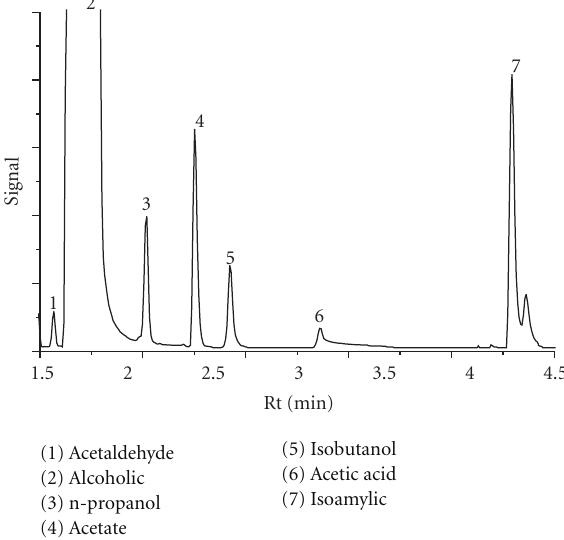
Figure 1: Chromatogram of a spirit from Cape